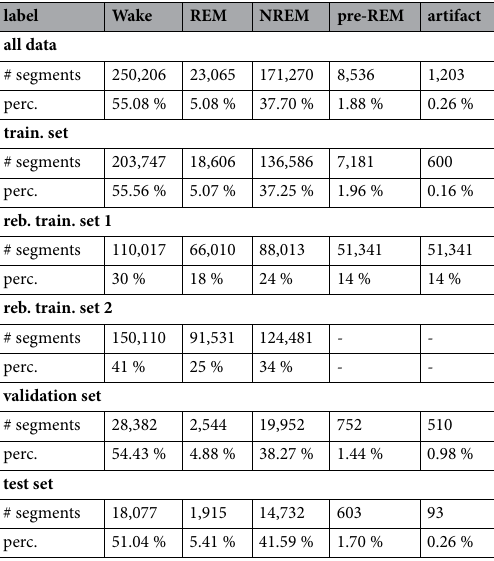
(AP: 2.0 mm, L: ±2.5 mm), and the reference electrode occipital (AP: -1.0 mm, L: 0 mm, relative to Lambda) according to the atlas of Franklin and Paxinos 39 . This setup was used to sample the electrical activity of the fron- tal, parietal-left, and parietal-right lobes. Two flexible stainless steel wires were inserted into the neck muscles to measure the EMG signal. During recordings, mice were plugged with a cable attached to a swiveling com- mutator, which was connected to the amplifier (Model 15A54, Grass Technologies, USA). The amplified (x1000) signals (EEG and EMG) were digitalized, filtered (EEG: 0.01–300 Hz; EMG: 30–300 Hz), and sampled at a rate of 992.06 Hz. The commutator units were built in-house. The software Spike2, version 6.07, was used for data acquisition and subsequent annotation. Manual sleep-stage classification. Our expert (SW) manually scored sleep by visual inspection of EMG and EEG time series. The parietal right EEG was chosen for scoring decisions because it had the best signal-to-noise ratio across all mice. Recordings were divided into non-overlapping consecutive windows (segments) of 10 sec- onds. Three consecutive segments of the EMG and the parietal right EEG signal were visually presented to the expert who scored the middle segment. The expert was not required to score the recordings in sequential order but could jump to other parts of the recordings at all times. Epochs containing features of multiple sleep stages were assigned the stage that made up the majority of the epoch. Segments were scored as stage “Wake”, “NREM”, “pre-REM”, or “REM” sleep (see Fig. 1 and Table 2). Arti- fact contaminated segments were scored as “artifact”. The Wake state is characterized by elevated activity in the EMG signals when compared with NREM, pre-REM, and REM sleep. NREM sleep is characterized by slow waves between 0.5–4 Hz (delta band) while REM sleep is associated with rhythmic activity between 7–8 Hz (theta band). The pre-REM stage is characterized by successive short bouts ( < 10 s) of high amplitudes similar to spindles and the appearance of a theta rhythm 13,17 . Wake was the most frequent stage in our dataset ( 55.08 % , see Table 2), followed by NREM ( 37.7 % ) and REM sleep ( 5.08% ). The intermediate stage pre-REM occurred only rarely ( 1.88% ) and only 0.26% of all segments were contaminated with artifacts. Dataset preparation for machine learning. Train-, validation-, and test-set splits. The scored time series were prepared for training and evaluation of the neural network for automated sleep scoring as follows: To mimic the manual scoring process and make our automated scoring system more flexible with respect to dif- ferent experimental setups (in which only one EEG derivation may be available), we chose to base the training of the neural network on the parietal right EEG only. The parietal right EEG time series were low-pass filtered using a 4-th order Butterworth low-pass filter (critical frequency: 25.6 Hz) in order to prevent aliasing effects due to subsequent downsampling. The low-pass filter was applied to each time series with a forward- and backward pass to avoid any phase shifts. Subsequently, the low-pass filtered time series were downsampled to 64 Hz by linear interpolation. The recordings were assigned to a training, a validation, and a test set (see Tables 1 and 2). Subjects were distributed such that each set consisted of recordings from mice of both dietary groups. Validation and test set each consisted of recordings from two mice one of which was from the altered-diet group. The mouse that passed